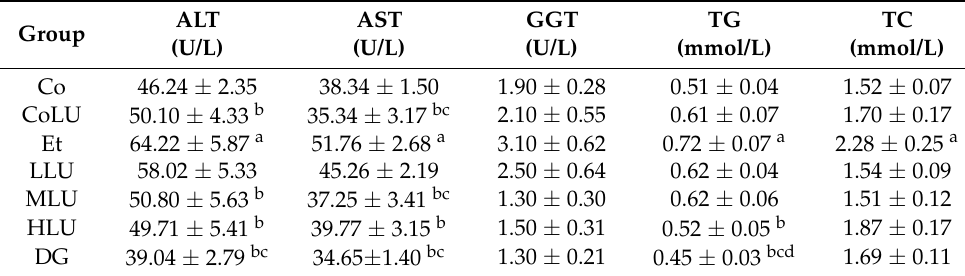
Table 3. Effect of Lutein on Serum Biochemical Indices.